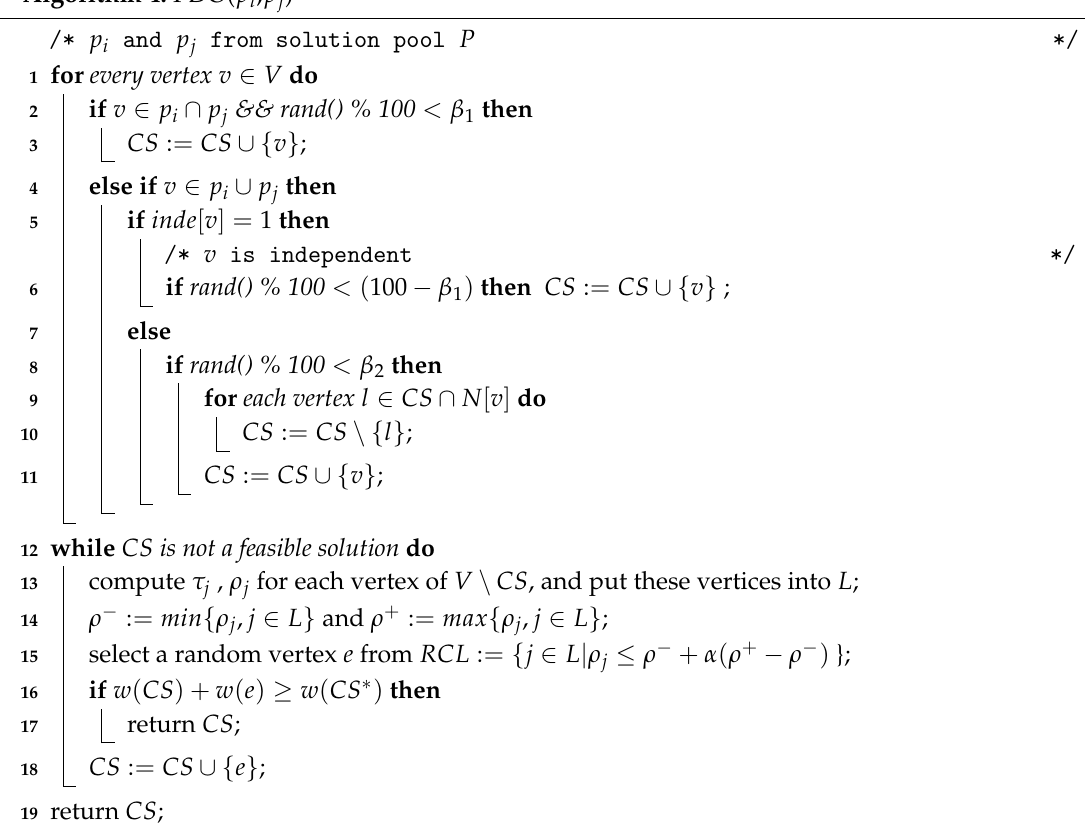
Algorithm 4: PDO( p i , p j